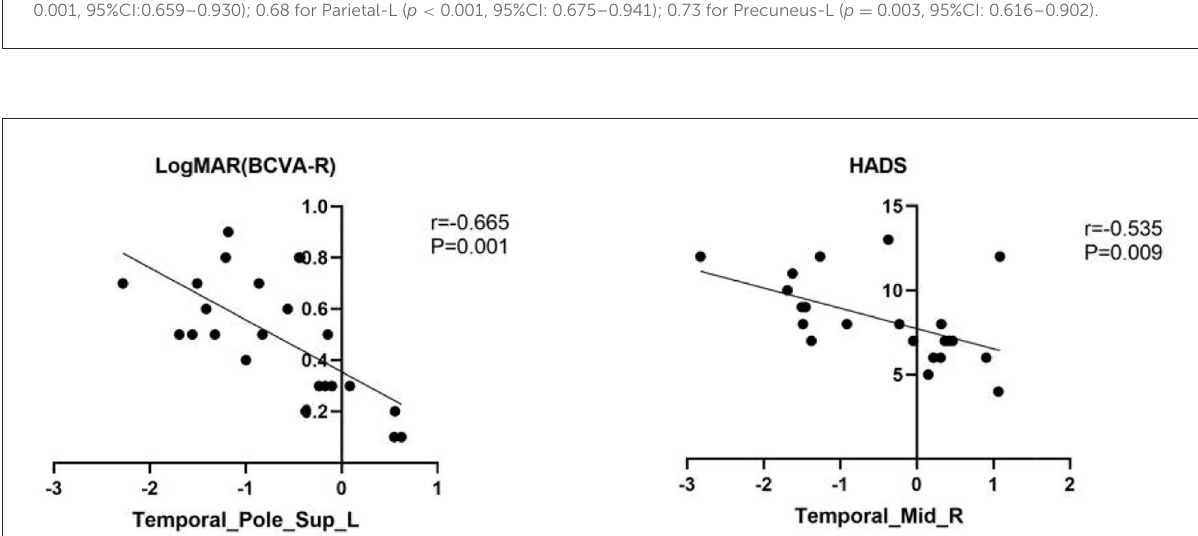
FIGURE4 The result of correlation analysis. The values of LogMAR(BCVA-R) of PAT presented a significant correlation with the fALFF values of Temporal-Pole-Sup-L. The scores of HADS showed a negative correlation with fALFF values of temporal_mid_R ( r = − 0.535, p = 0.009).